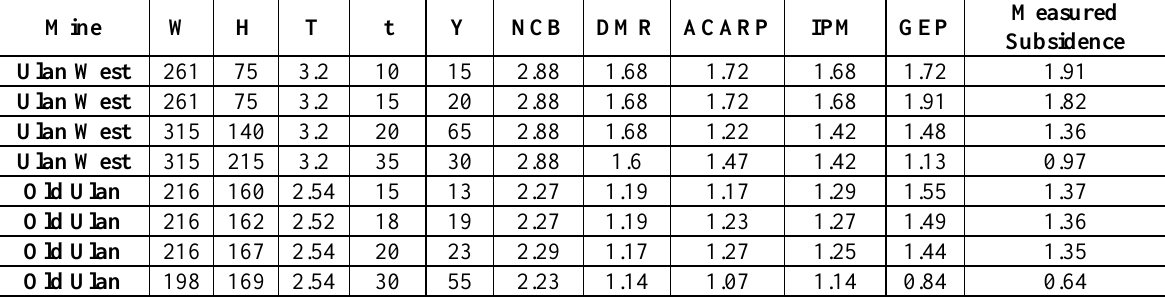
Table 8: Subsidence prediction results in the most applicable empirical methods for prediction of mine subsidence in Australia. Mine Ulan West